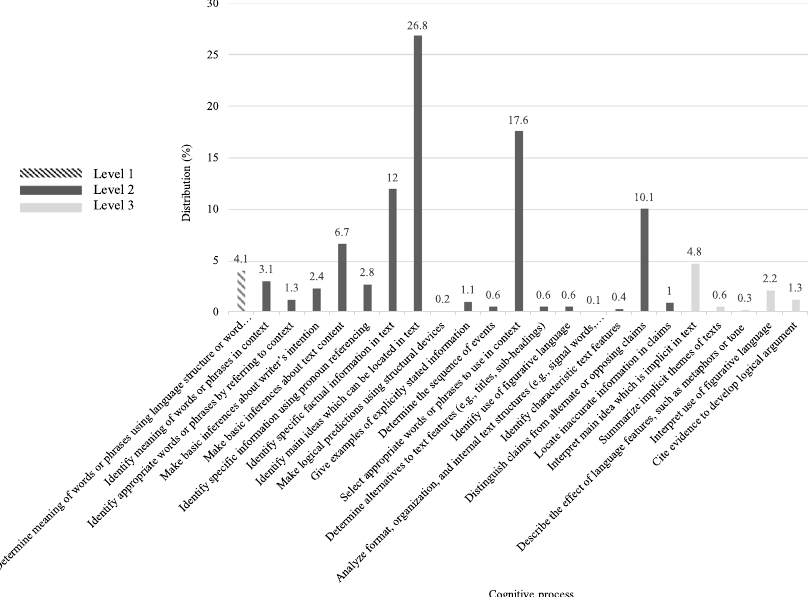
Fig. 3 Distribution of reading literacy processes across all years. *The percentage numbers add up to 100%